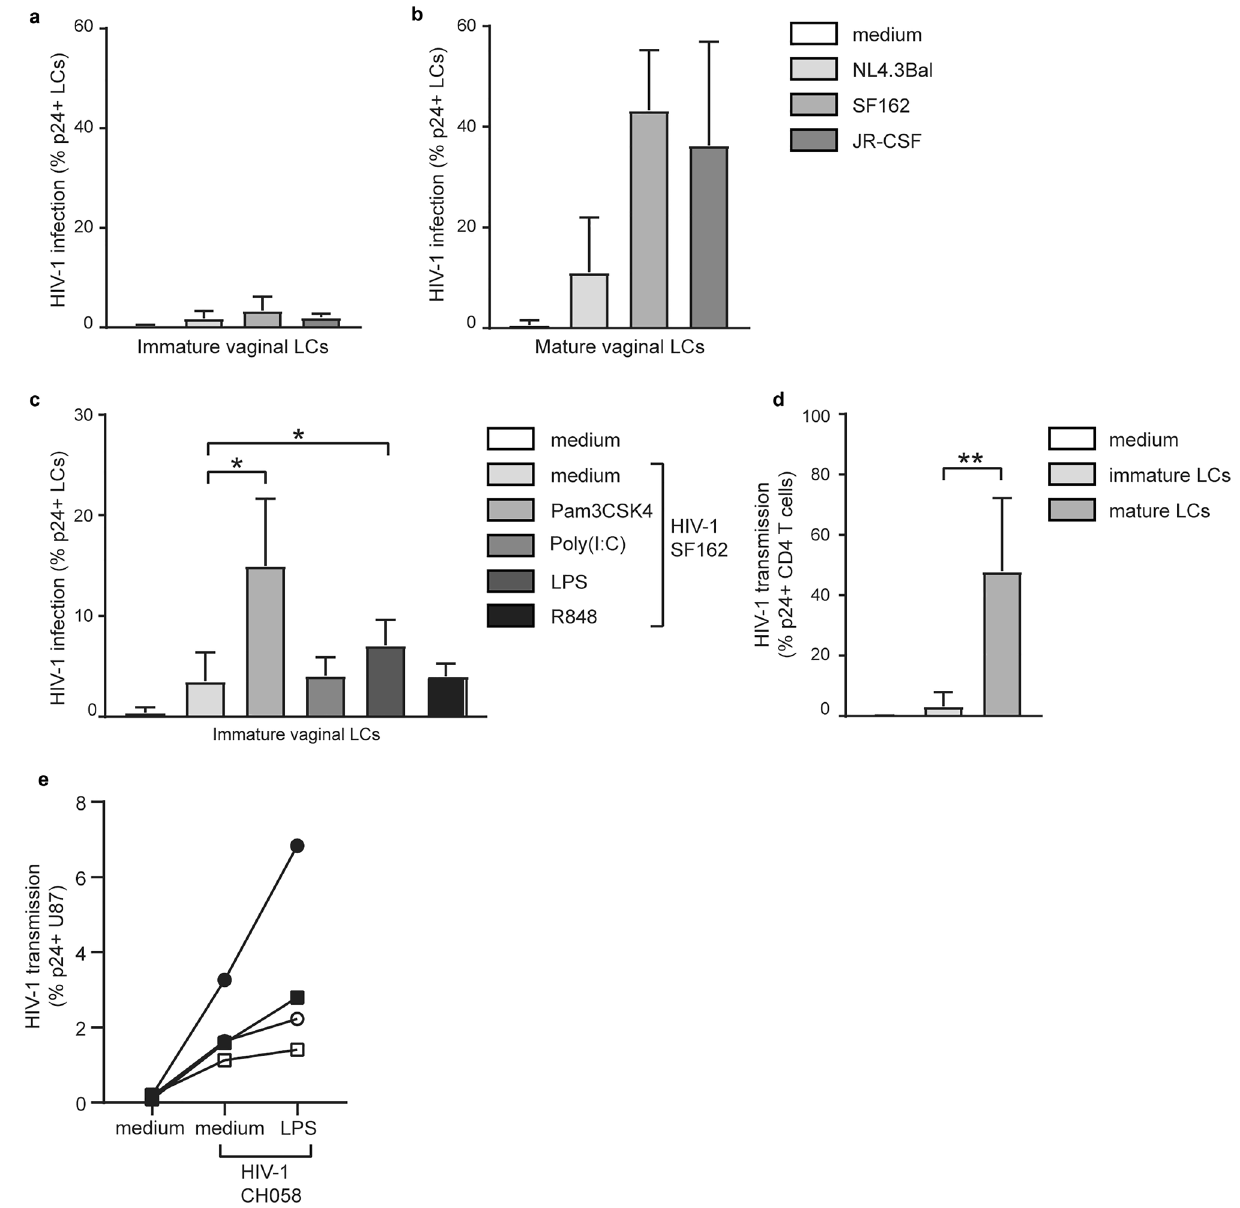
(( b ), N = 2–5) vaginal LCs (CD1a + , langerin high ) as measured by double staining for intracellular p24 and CD1a, and analyzed by flow cytometry; ( c ) HIV-1 (SF162) infection in immature vaginal LCs pre-stimulated with TLR- ligands, N = 4–7 * p < 0,05, two-tailed t- test, ( d ) HIV-1 (SF162) transmission from immature and mature vaginal LCs to CD4 T cells after co-culture, N = 3–5, ** p < 0.01, two-tailed t- test, (( e ), N = 4) HIV-1 transmitted/founder virus (CH058) transmission by immature vaginal LCs to CD4/CCR5 expressing U87 cells with or without prior stimulation or LPS for 30 min, data are mean ±